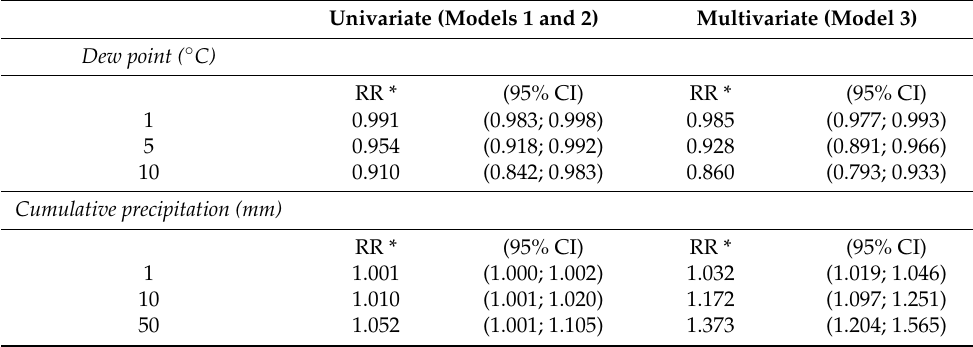
Table 3. Weekly influenza and weekly mean dew point and cumulative precipitations proxy. Results of the univariate (models 1 and 2) and multivariate model (model 3).